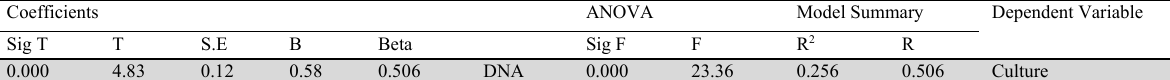
The results of the simple regression analysis for exploring the impact of the organizational DNA doesn’t on organizational culture in commercial banks in Madaba